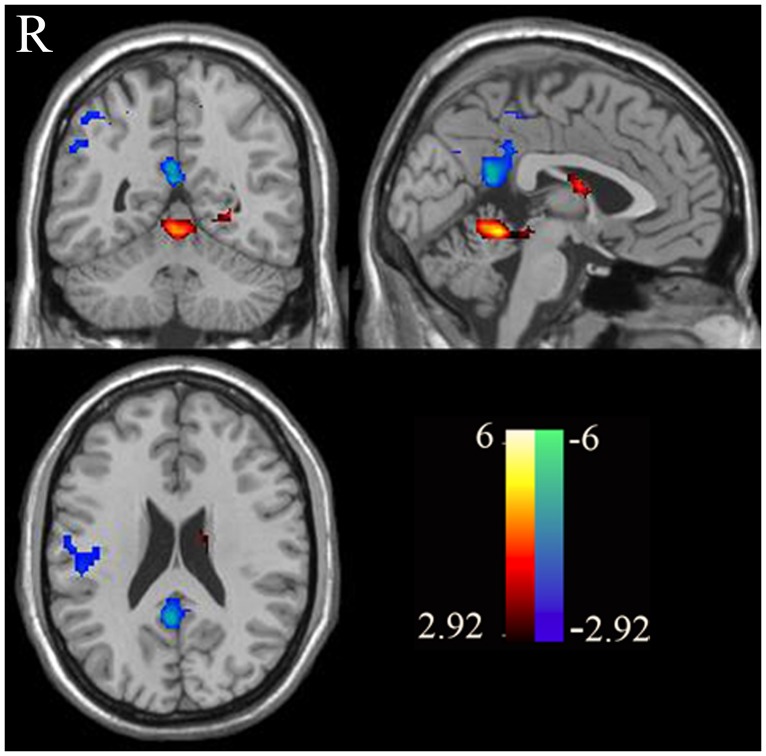
Brain regions showing self-other activation in the control group.One-sample tests produced the spatial patterns of brain regions showing self-other activation for both healthy controls. Warm colors represent positive while cool colors indicate negative activation. The above result was obtained with threshold p < 0.01, AlphaSim correction p< 0.01.